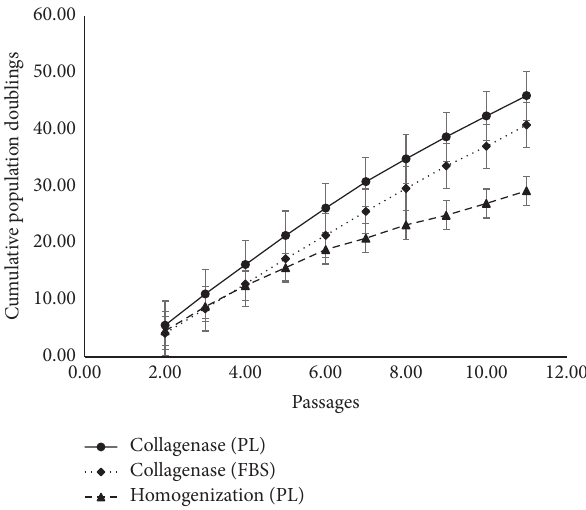
Figure 3: UC-MSCs continue to expand robustly in culture at the end of 10 passages. Cumulative population doublings achieved over the duration of culture demonstrate the replicative capacity of UC- MSCs generated using Col-D or t-H. Error bars denote mean ± SD.